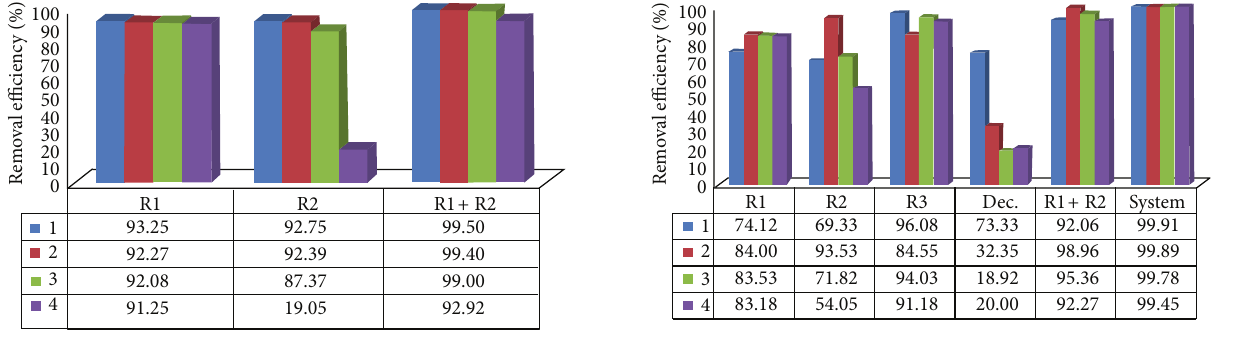
Figure 3: Removal efficiency of total coliforms in the UASB reactors (R1 and R2) placed in series, at pilot scale, for treatment system I, in assays 1, 2, 3, and 4.